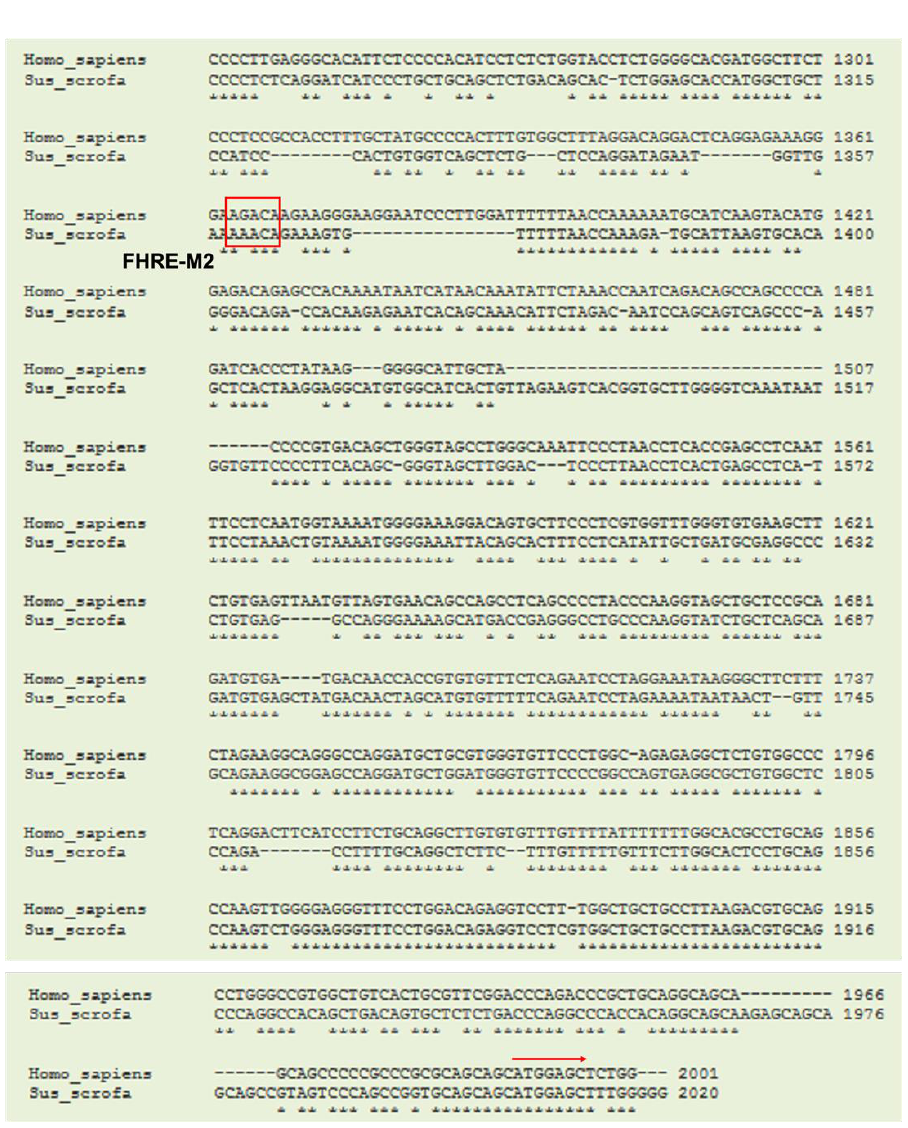
Figure 5. Sequence alignments of the putative porcine TN promoter by the ClustalW program. A 1956-bp sequence of putative porcine tetranectin (TN/ CLEC3B ) promoter was cloned and aligned to that of the human sequence. The porcine sequence had 65% homology to the human TN promoter. Red boxes indicate consensus elements of binding sites, sterol regulatory elements (SRE) for SREBP-1c and forkhead response elements (FHRE) for FoxO in the pig and human sequences. The red arrow indicates the translation initiation site.